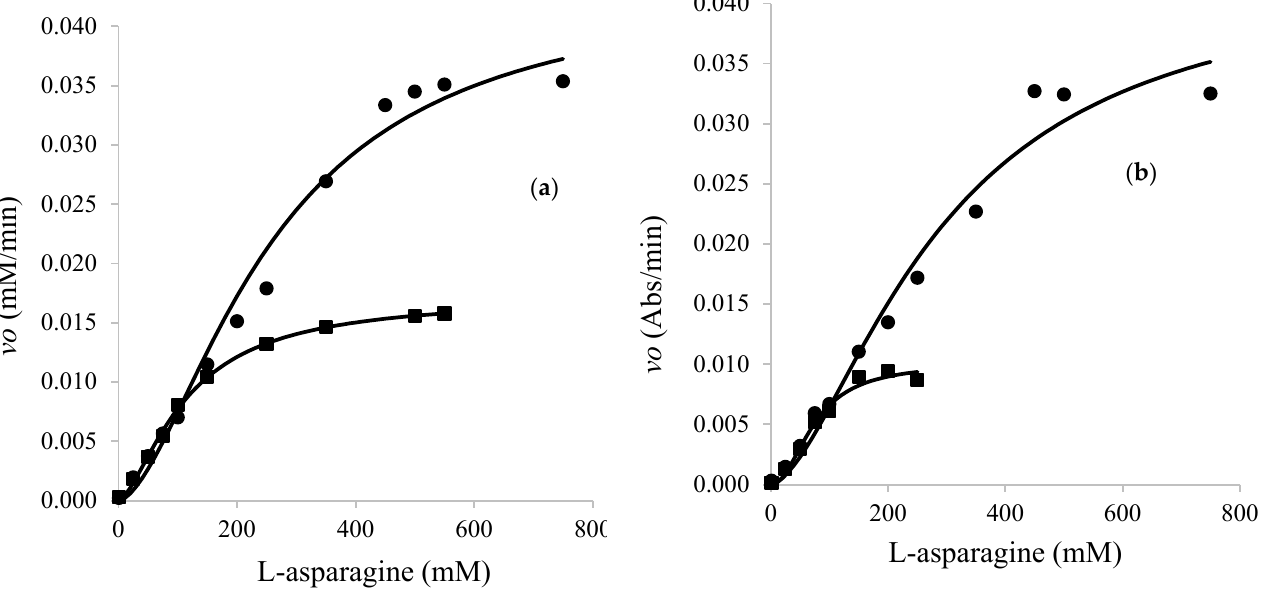
Figure 7. Initial reaction rates ( v 0 ) for both ( ● ) free and ( ■ ) immobilized L-asparaginase (ASNase) onto ( a ) pristine and ( b ) functionalized multi-walled carbon nanotubes (f-MWCNTs-1020) by physical adsorption. The solid lines represent the experimental data fit to the Hill equation.